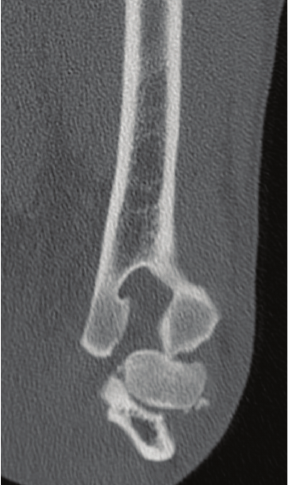
Figure 2: Transverse bone algorithm [B60] image of left elbow at the level of the coronoid before reduction demonstrating caudal luxation of the humeroradial and humeroulnar joint. Two well- defined smoothly marginated mineral opacities were also noted; measuring approximately 3 mm and 1mm, respectively, on the caudal lateral aspect of the radius at the level of the medial coronoid process of the ulna. The medial coronoid appears sclerotic and irregularly